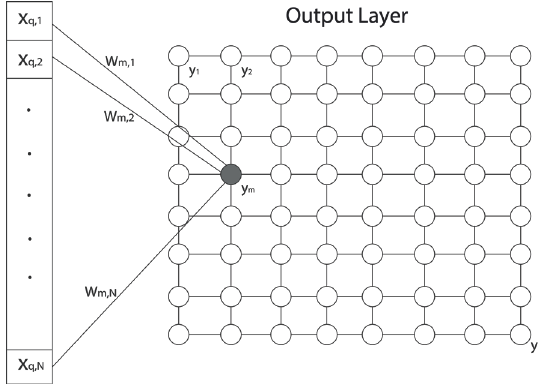
Fig. 5. Kohonen map layers: Input Layer (Left), Output Layer